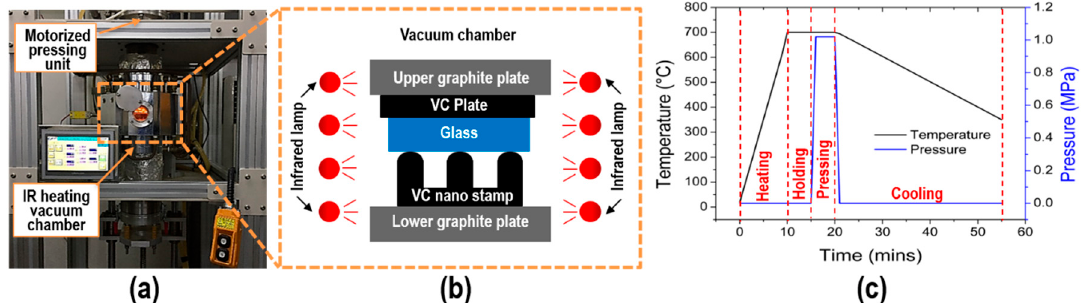
Figure 3. ( a ) Image and ( b ) schematics of glass imprinting system, in addition to set-up and ( c ) pressure and temperature histories of the glass imprinting process.